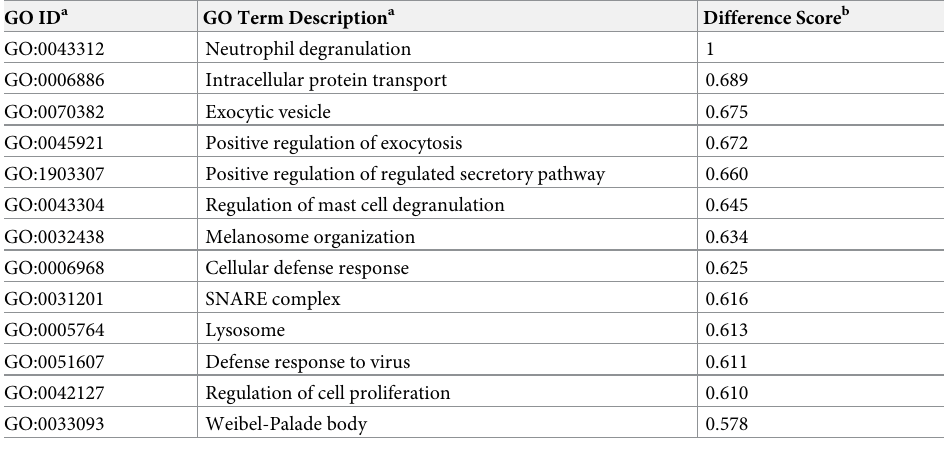
Table 1. GO terms associated with the HLH gene set, identified by KnowEnG’s network-guided gene set charac- terization pipeline using HumanNet Integrated network. GO ID a GO Term Description